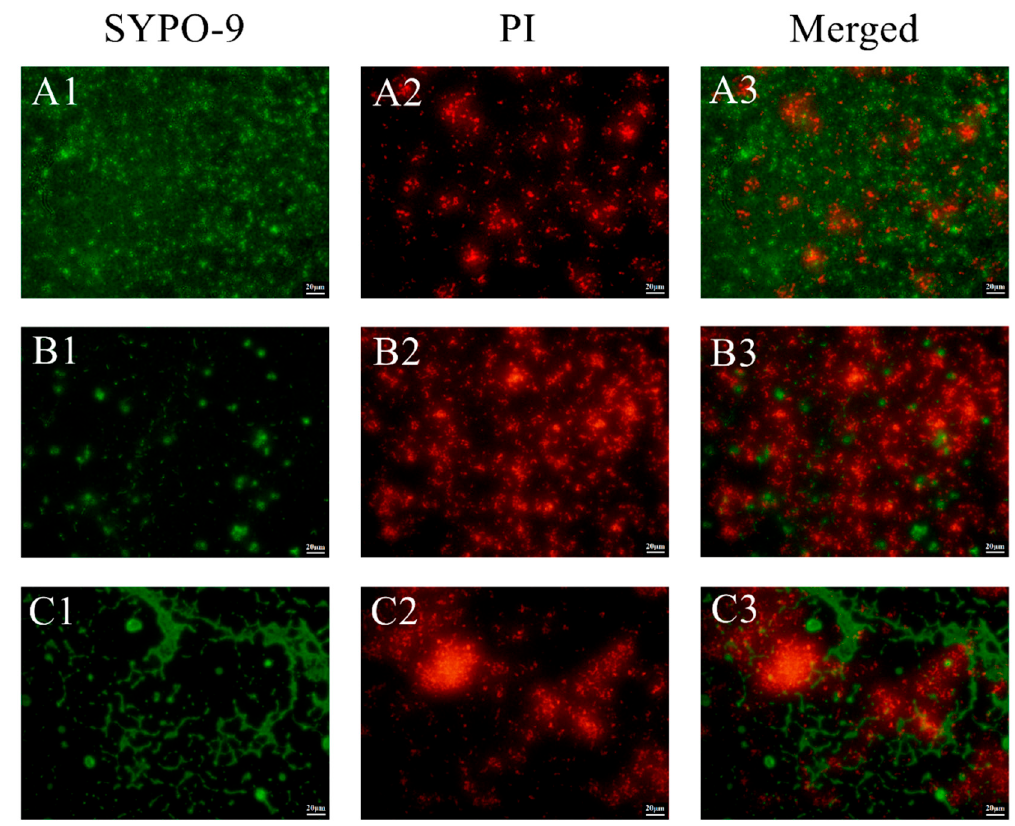
Figure 3. CLSM images of P. gingivalis biofilm treated with L. mesenteroides LVBH107. Live strains were stained green, whereas dead strains were stained red using the LIVE/DEAD ® BacLight™ Bacterial Viability kit (L7012, Thermo Fisher Scientific, Waltham, MA, USA) ( A ) Untreated control. ( B ) Treatment with L. mesenteroides LVBH107 culture medium. ( C ) treatment with the supernatant of L. mesenteroides LVBH107. (1) Stained with green fluorescence (SYTO9). (2) Stained with red fluorescence (PI). (3) Indicated merge of red and green fluorescence. Scale bar = 20 μ m.